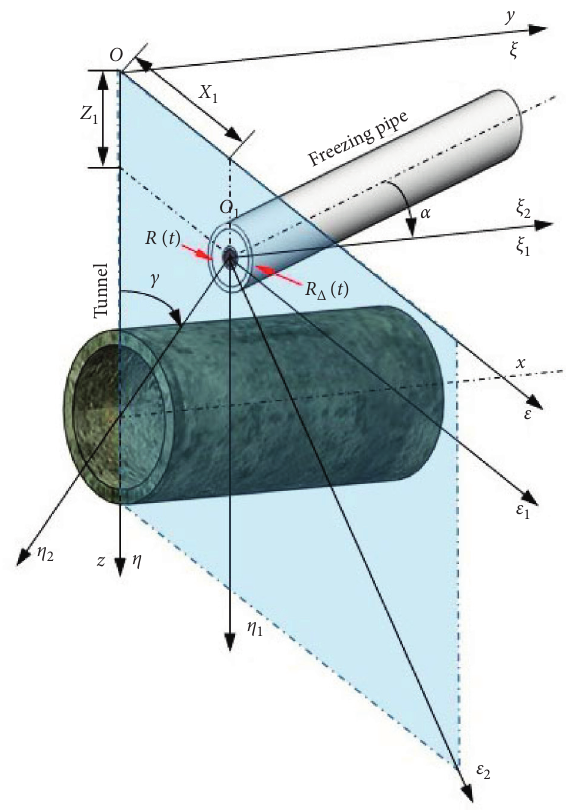
Figure 2: 3D layout of freezing